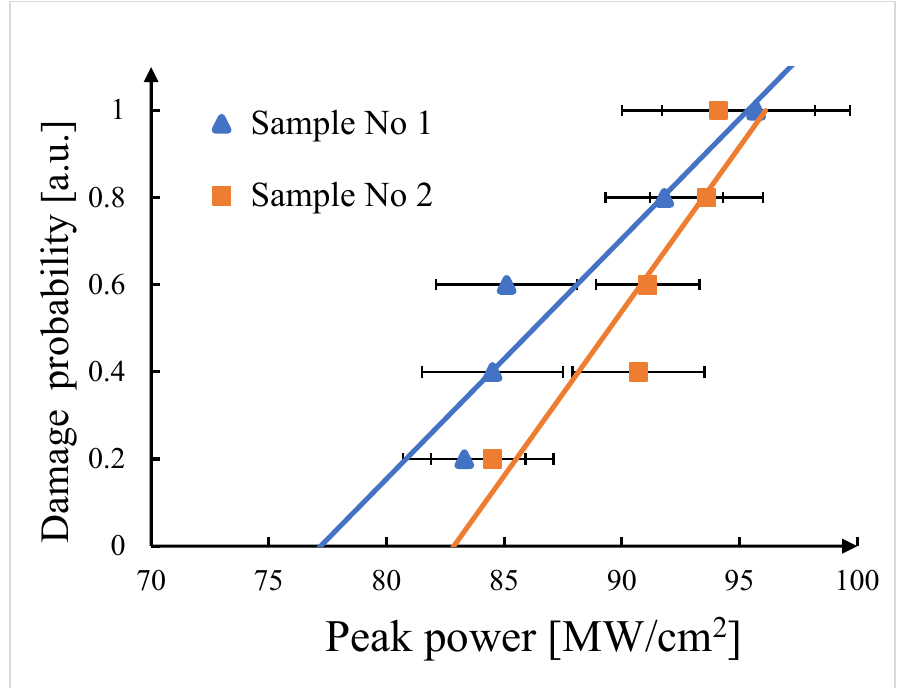
Figure 6. Dependence of the optical breakdown probability of samples No. 1 ( ∆ ) and No. 2 ( (cid:3) ) on the power density of the incident laser radiation .